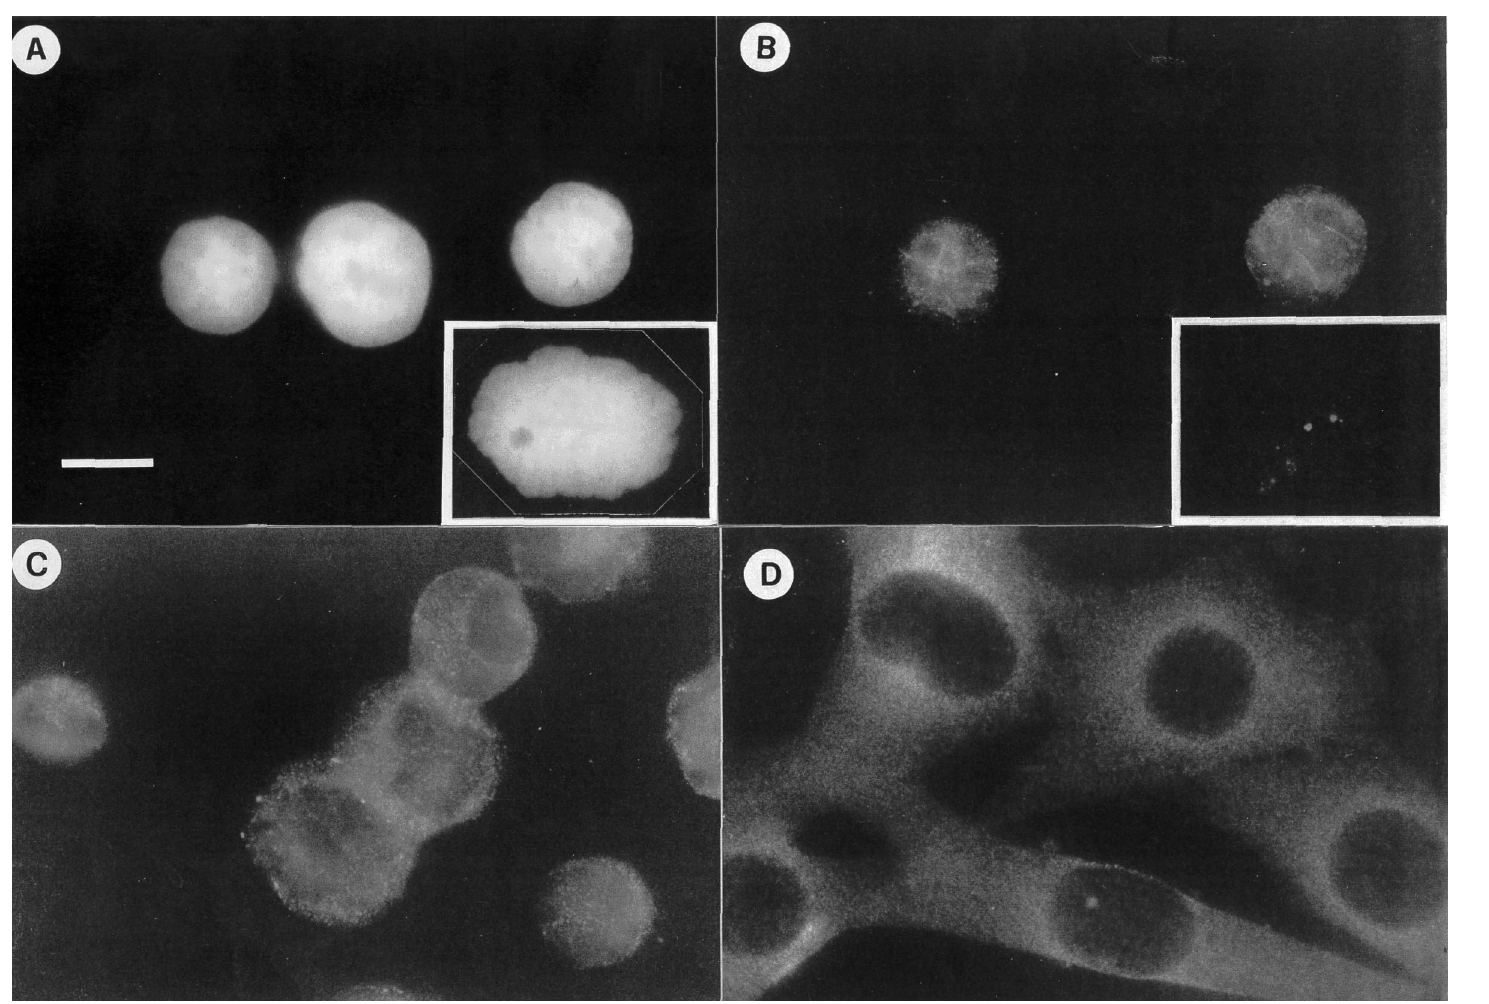
Fig. 5. Nuclear DNA DAPI staining is reported in picture (A). AS-2 immunostaining of the same field is shown in picture (B). While positive nuclei appear stained with interdispersed fluorescence, negativity of the central nucleus is evident. A mitotic cell is shown in the window, stained with DAPI ((A), left side) and with AS-2 ((B), right side) for which AS-2 staining is limited to two little dot-like regions opposite to each other. AS-2 cytoplasmic staining patterns for entire cells are shown for K562 (C) and HeLa cells (D), respectively. K562 were cytocentrifuged before fixation while HeLa cells were grown and fixed directly on slides. Bar = 20 (cid:22) m for all the